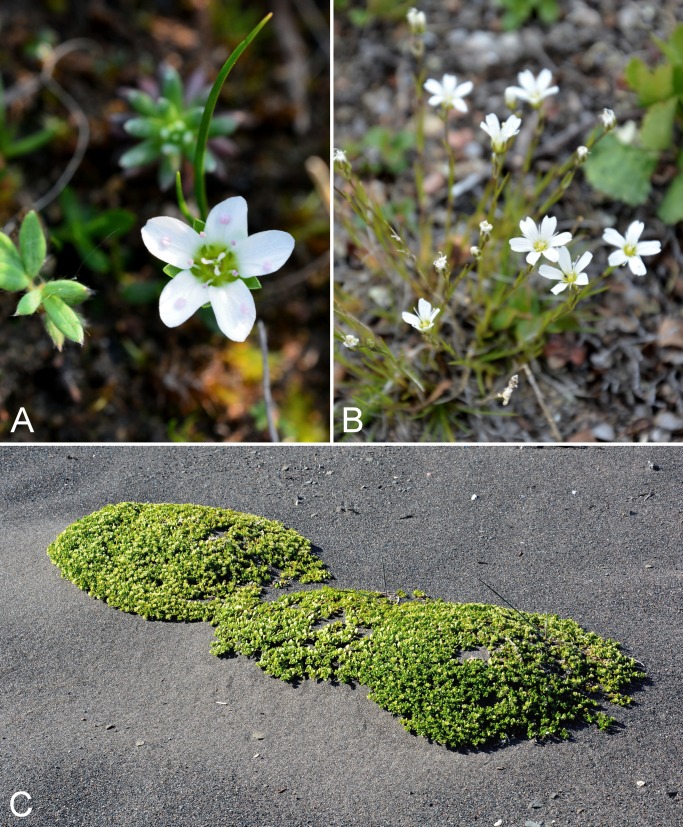
Arenaria humifusa, Eremogone capillaris subsp. capillaris and Honckenya peploides subsp. diffusa.Arenaria humifusa: (A) habit, Saarela et al. 3264. Eremogone capillaris subsp. capillaris: (B) habit, Saarela et al. 3570. Honckenya peploides subsp. diffusa: (C) habit, Saarela et al. 3708. Photographs by P. C. Sokoloff.